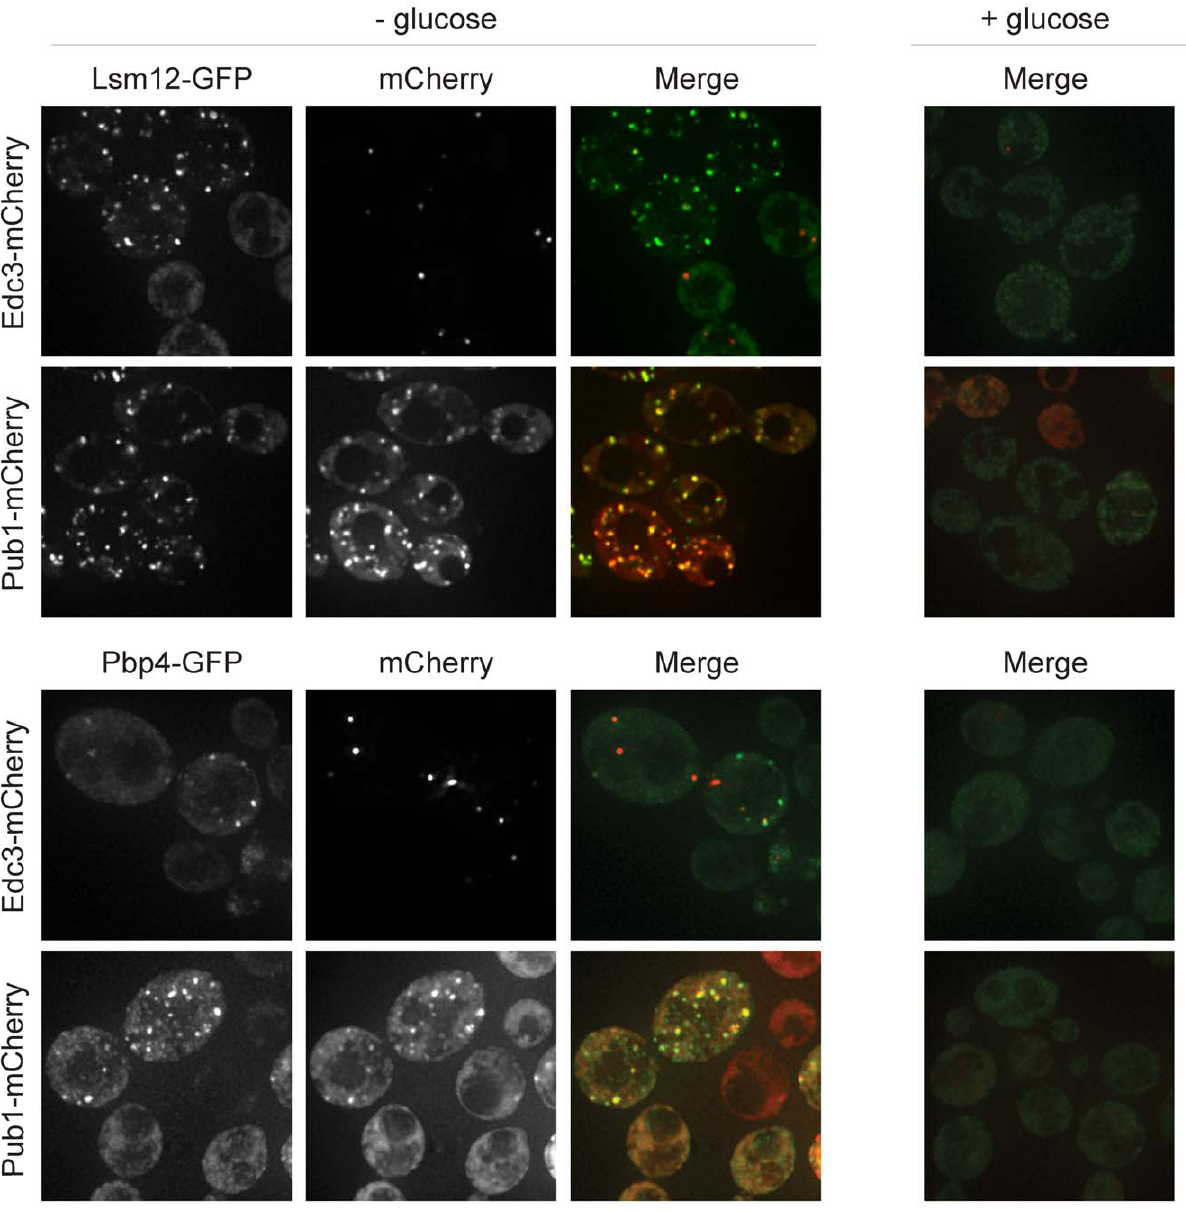
Figure1. Lsm12andPbp4 localizetostressgranules. GFP-tagged Lsm12 andPbp4 wereassessed fortheirability to form granulesthat co-localize with either Edc3-mCherry, a P-body marker, or with Pub1-mCherry, a stress granule marker, following ten minutes of glucose deprivation stress.